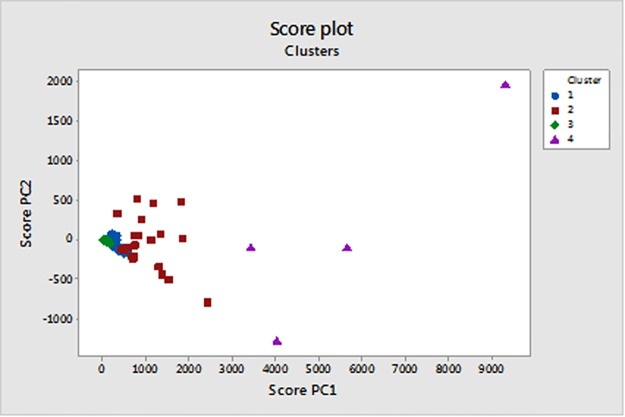
Score plot PC2 vs PC1 with clustering results.